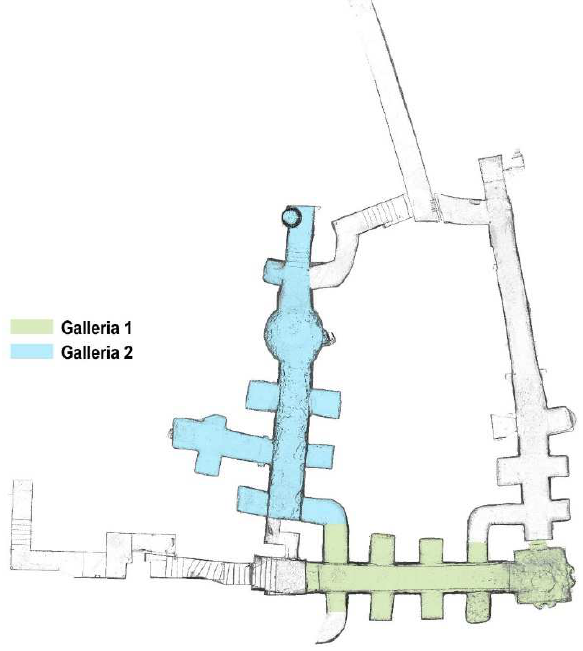
Figure 3: Campana caves plan. The caves are developed according to a ring path, the branch in green is the gallery number 1 and the blue one is number